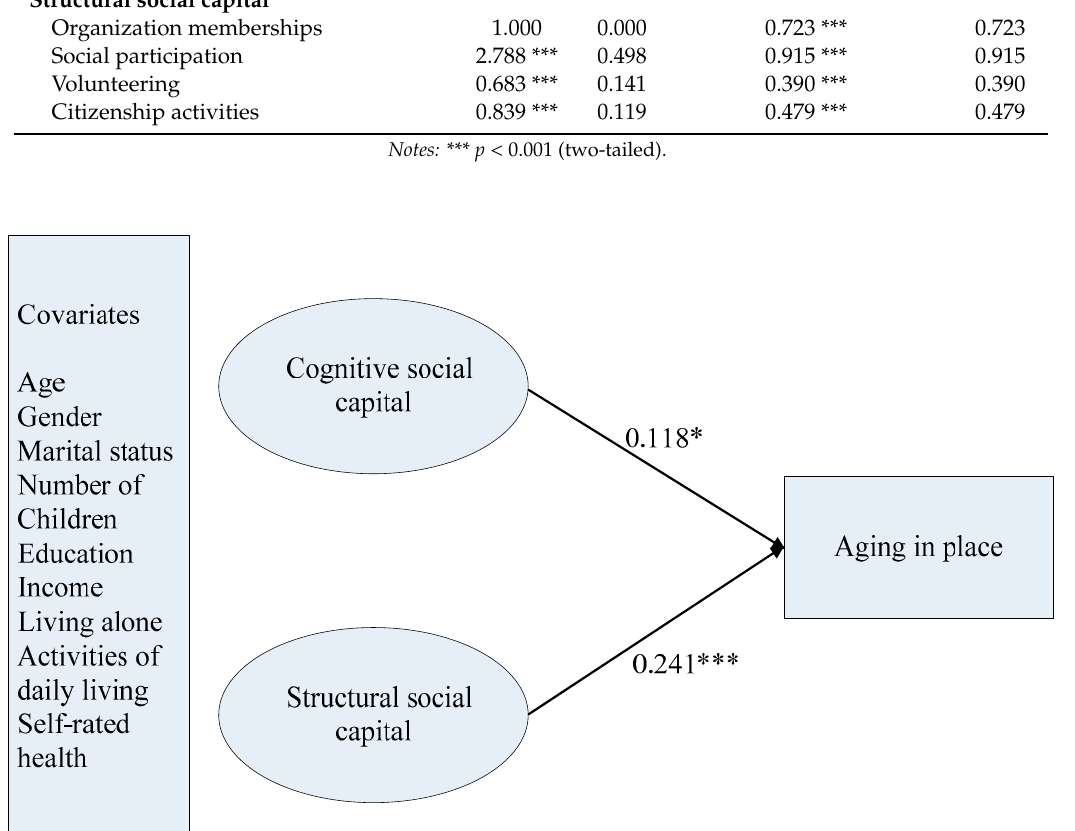
Figure 1. Final model of social capital and aging in place. Notes: Standardized coefficients are reported. * p < 0.05 (two-tailed); *** p < 0.001 (two-tailed).